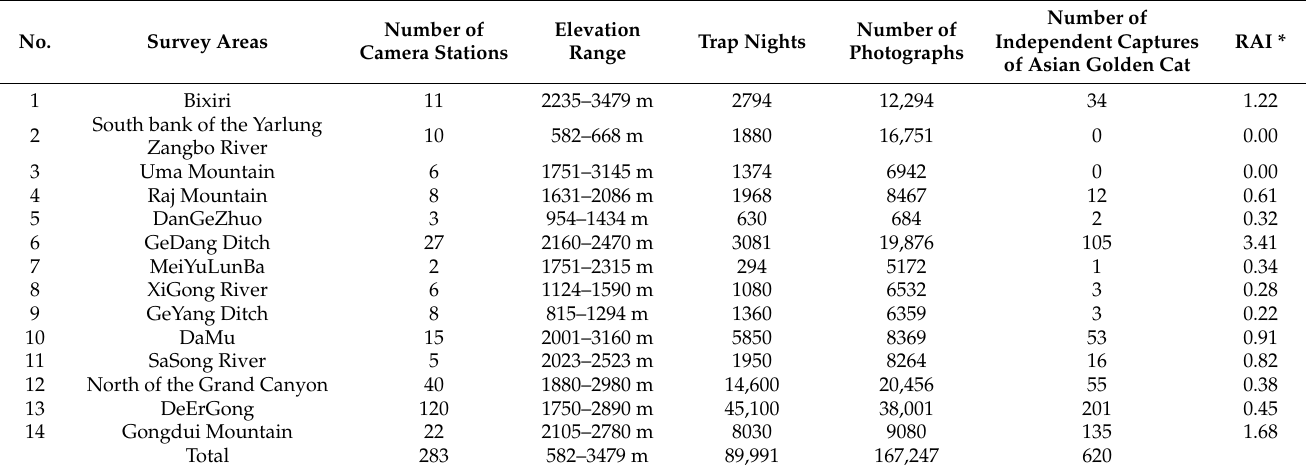
Table 1. Camera-trapping efforts and the number of independent photographs of the Asiatic golden cat in 14 survey areas for